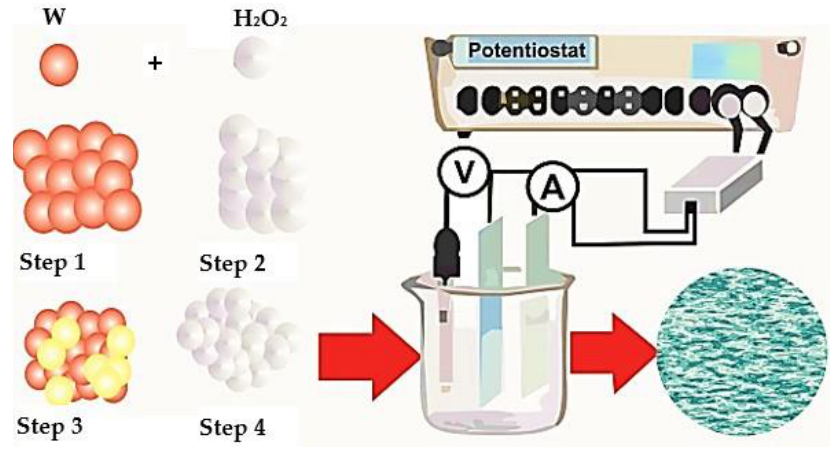
Figure 26. Growth mechanism of electrodeposited WO 3 film.